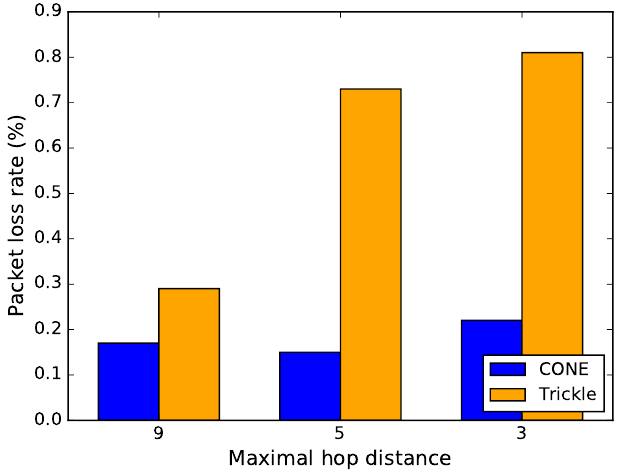
Figure 14. Comparison of average packet loss of nodes due to MAC